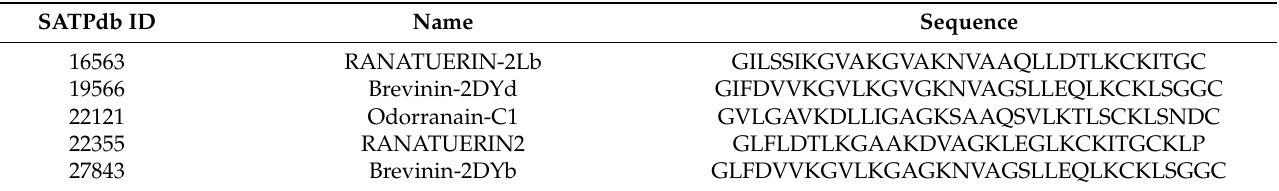
Table 5. Sequence information of 5 peptides.